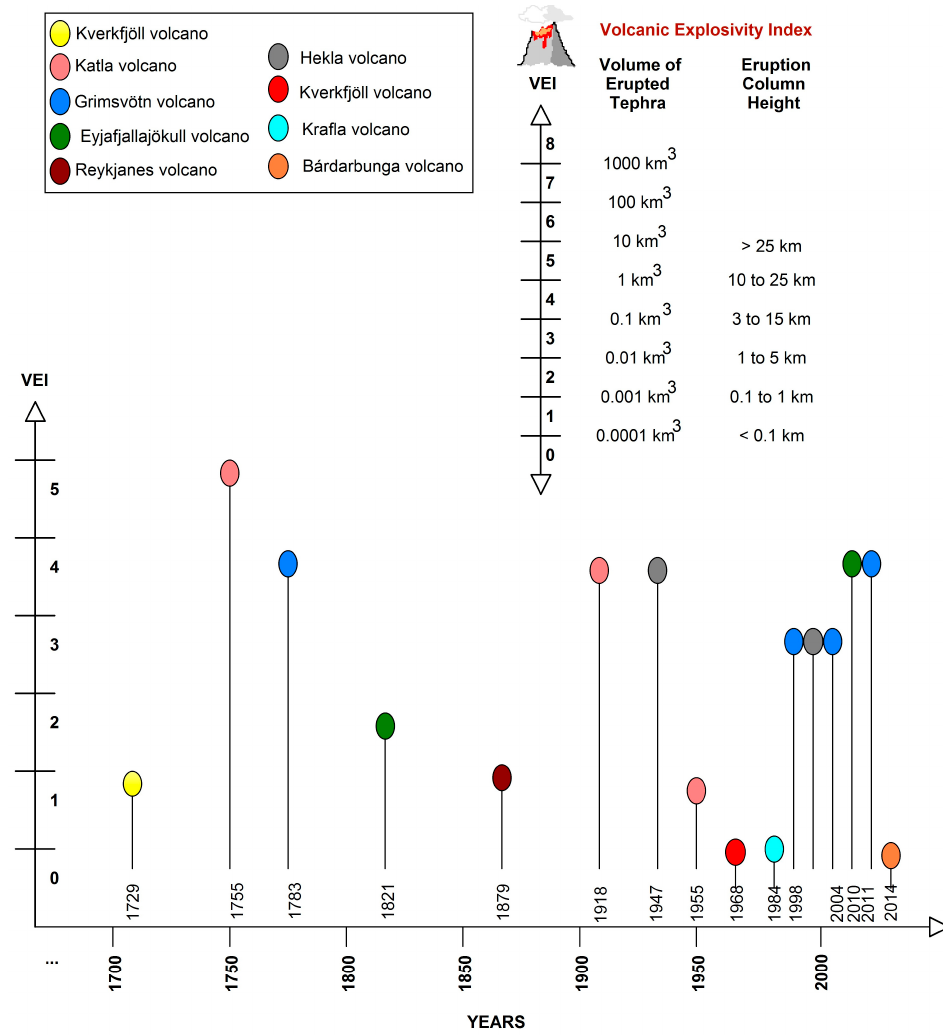
Figure 1. Selected volcanic activity of main volcanoes situated in Iceland.